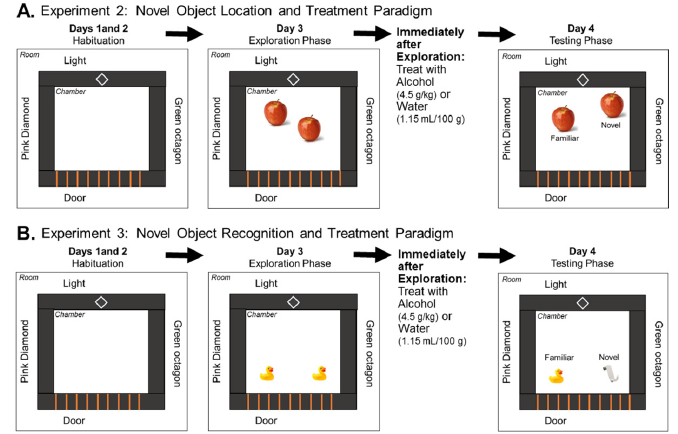
Figure 1. Experimental Paradigm for Novel Object Location (Experiment 2) and Novel Object Recognition (Experiment 3). Male and female rats were treated prenatally with alcohol or water and allowed to grow